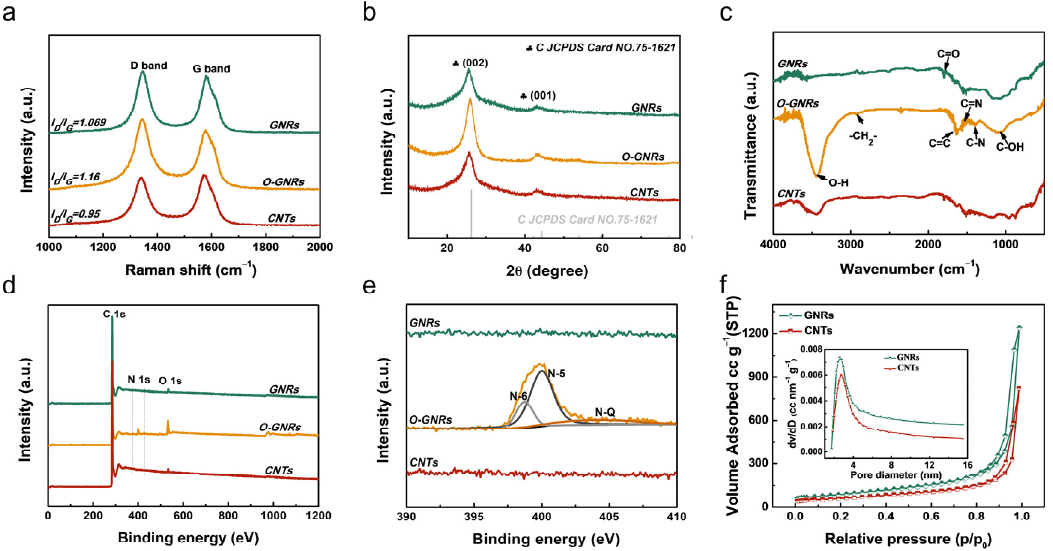
Figure 2. ( a ) Raman and ( b ) XRD spectra of the CNTs, O-GNRs, and GNRs. ( c ) FI-IR spectra of CNTs, O-GNRs, and GNRs. ( d ) XPS survey spectra and ( e ) N 1s spectra of the CNTs, O-GNRs, and GNRs samples. ( f ) N 2 isotherm adsorption–desorption curves of CNTs and GNRs inset shows the corresponding BJH pore size distribution curves.